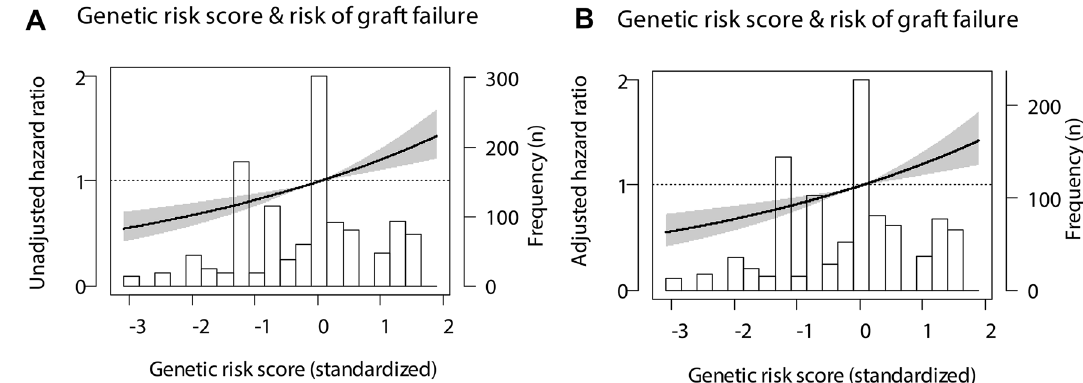
Figure 6. Linear splines of the association of the IL-6/IL-6R genetic risk score with rejection. Data were fit by a Cox proportional hazard model for all splines ( A ) unadjusted or ( B ) adjusted for the recipient age, recipient sex, total number of HLA-mismatches and the occurrence of delayed graft function (DGF). The hazard ratio is represented by the black line, the 95% confidence interval by the grey